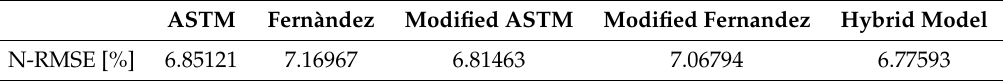
Table 2. Normalized RMSE associated with each model.